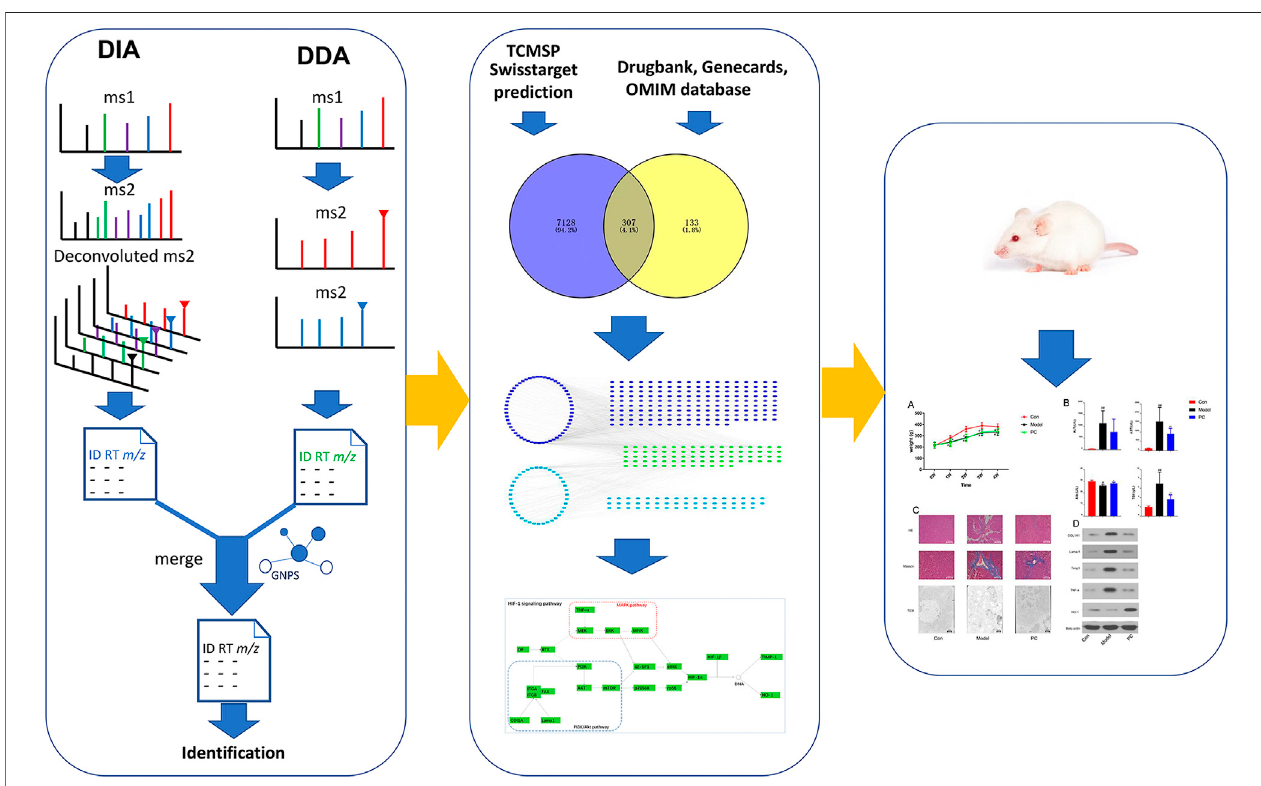
FIGURE 1 | Strategy work fl ow for this study